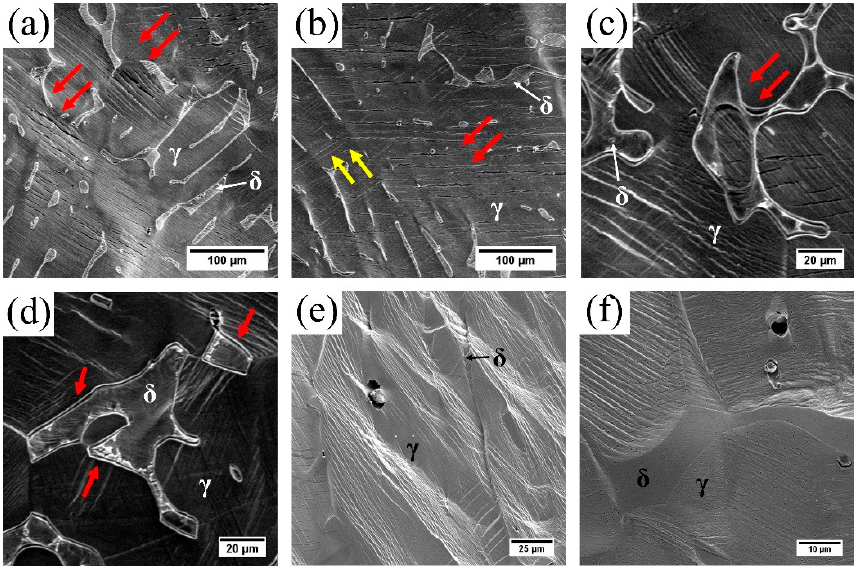
Figure 9. Crack sites in the Z3CN20.09M CDSS during tensile tests. In Figure ( a ) and Figure ( b ), small cracks initiated in the austenite phase. In Figure ( c ) and Figure ( d ), the interface boundaries of austenite/ferrite phase were separated. In Figure ( e ) and Figure ( f ), the cracks were formed adjacent to the impurities. Figure ( a ) to ( d ) were from the samples under the “as received, 320 °C” condition tested by Shimadzu SS550, Figure ( e ) and ( f ) were from the samples under the “aged 2000 h, 320 °C” condition which were imaged by SEM after tensile tests. The tensile axis moves along the vertical direction in all the figures.